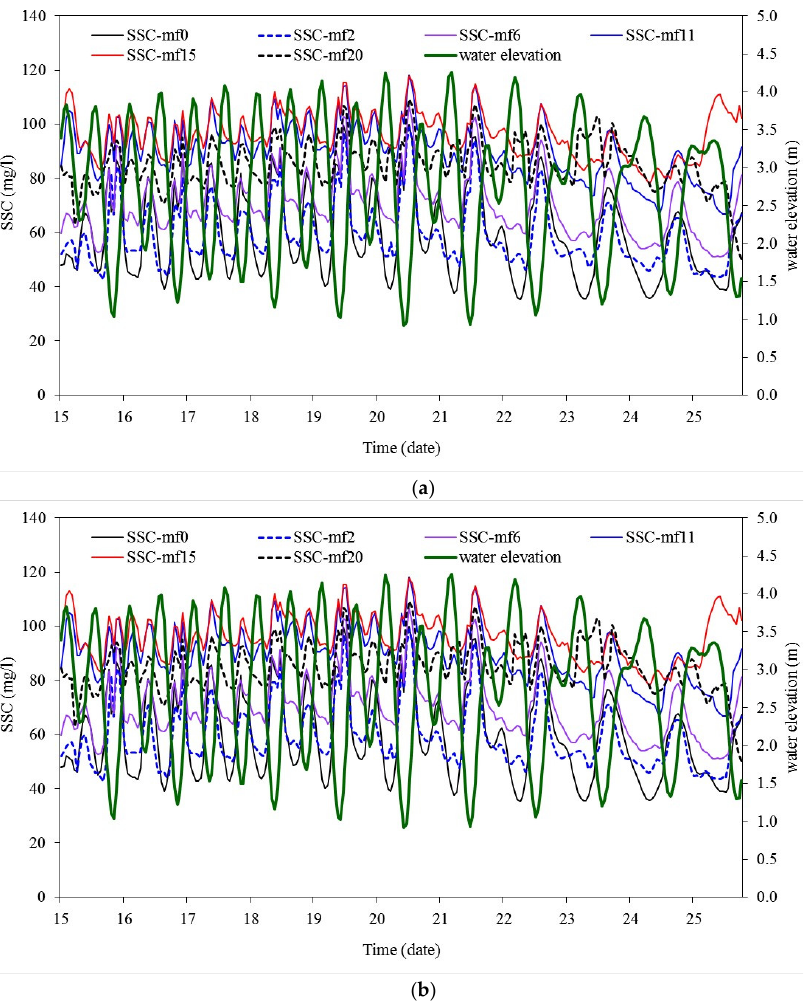
Figure 5. Temporal variation of SSC under some scenario simulations during 11 days of the 14.75 neap-spring cycle, in the flood season: ( a ) at station LT3 to the NE; ( b ) at station LT1 to the